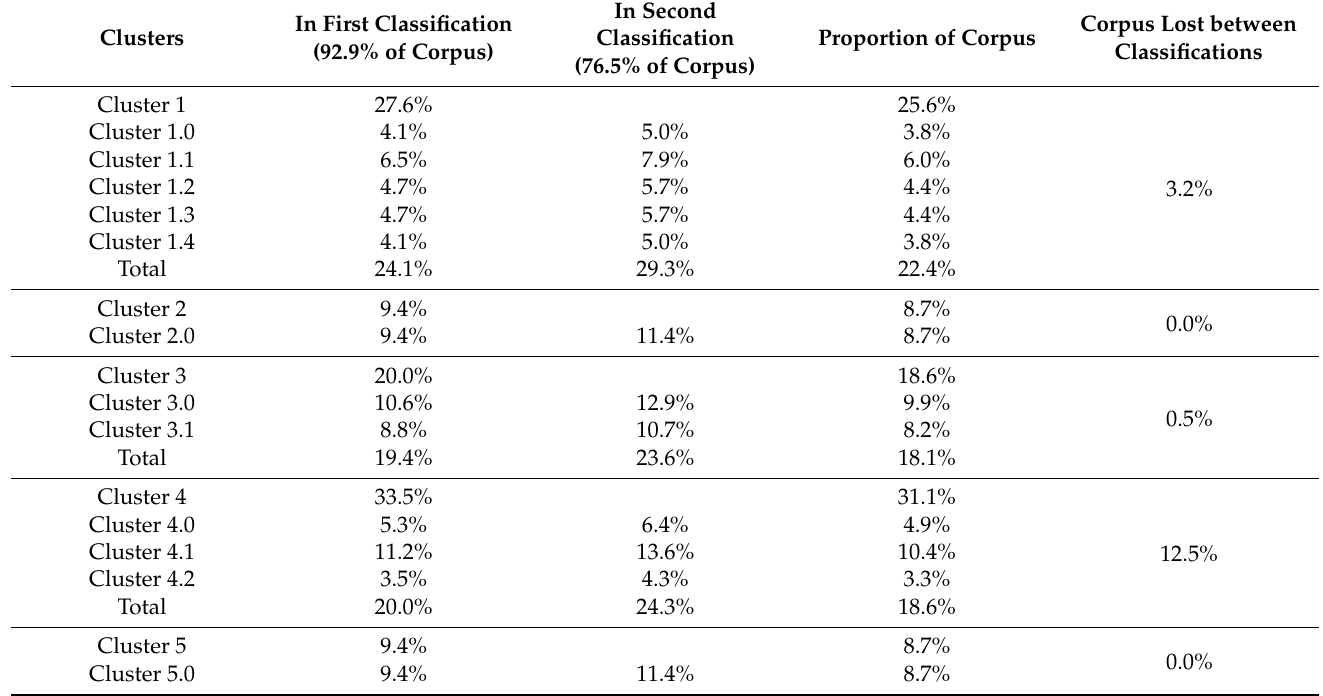
Table 3. Proportion of corpus included and loss of data between